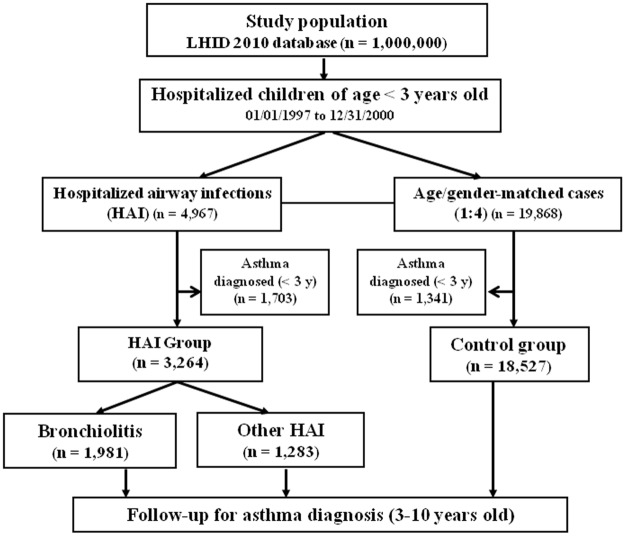
Flow chart of case enrollment from the National Health Insurance Research Database in Taiwan.LHID 2010, Longitudinal Health Insurance Database with random sampling of beneficiaries enrolled in 2010.